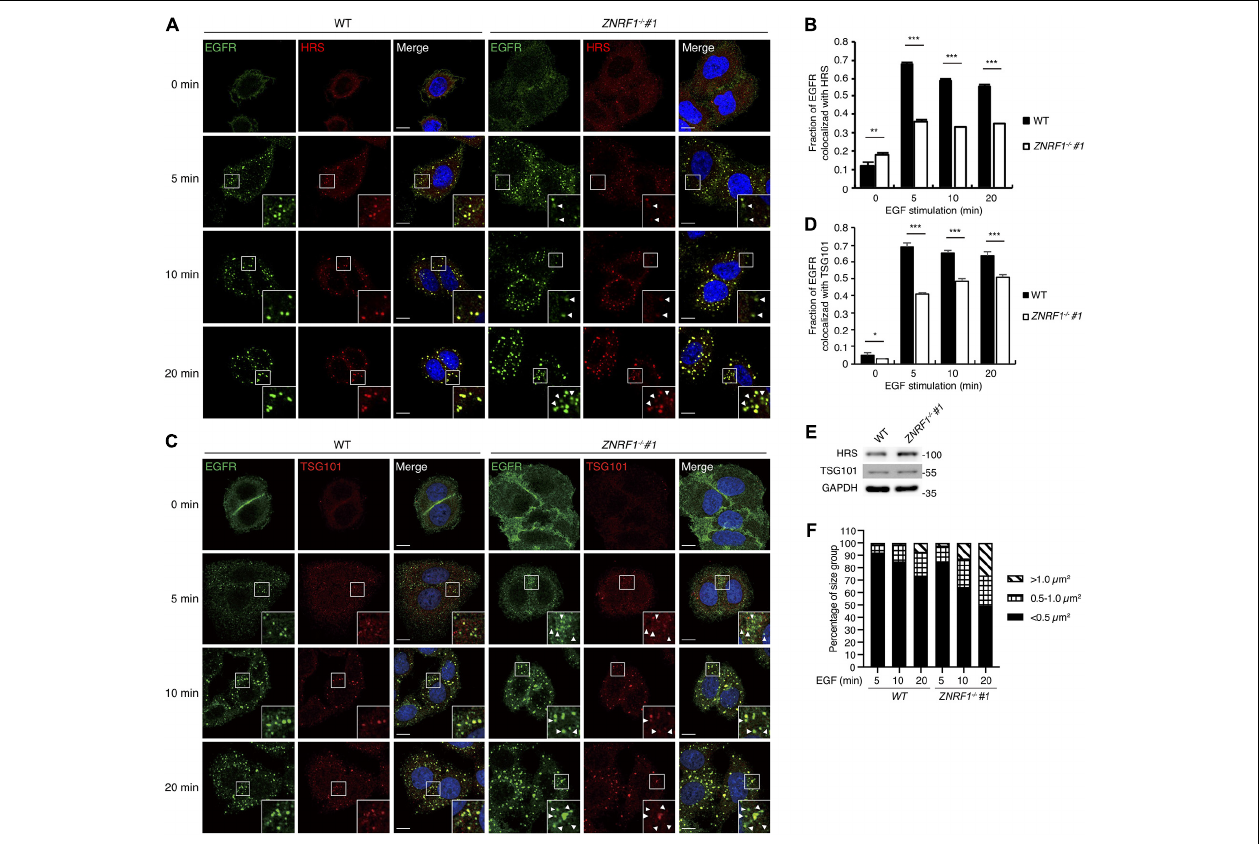
FIGURE 6 | ZNRF1 mediates the recruitment of ESCRT machinery to internalized EGFR. (A–D) Wild type or ZNRF1 − / − A549 cells were serum-starved overnight and stimulated with 100 ng/mL EGF for 0, 5, 10, and 20 min. (A) Cells were co-stained with EGFR (Green) and HRS (Red) antibodies. (B) Quantification of the fraction of EGFR co-localized with HRS in (A) . (C) Cells were co-stained with EGFR (Green) and TSG101 (Red) antibodies. (D) Quantification of the fraction of EGFR co-localized with TSG101 in (C) . (E) Cell lysates from wild type and ZNRF1 − / − A549 cells were prepared and the levels of HRS and TSG101 were analyzed by immunoblotting. (F) Quantification of the size distribution of EGFR puncta in (A) . White arrows indicate non-colocalized signals. Scale bar, 10 µ m. Data are presented as mean ± SEM. n > 1000 puncta from at least 50 cells for each group; * P < 0.05; ** P < 0.01; *** P < 0.001. All experiments were repeated two to three times with similar